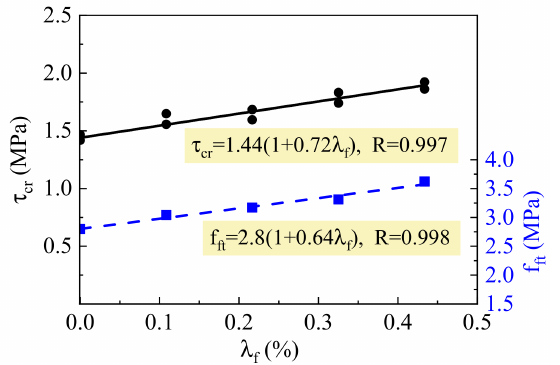
Figure 6. Changes of τ cr and f ft with λ f